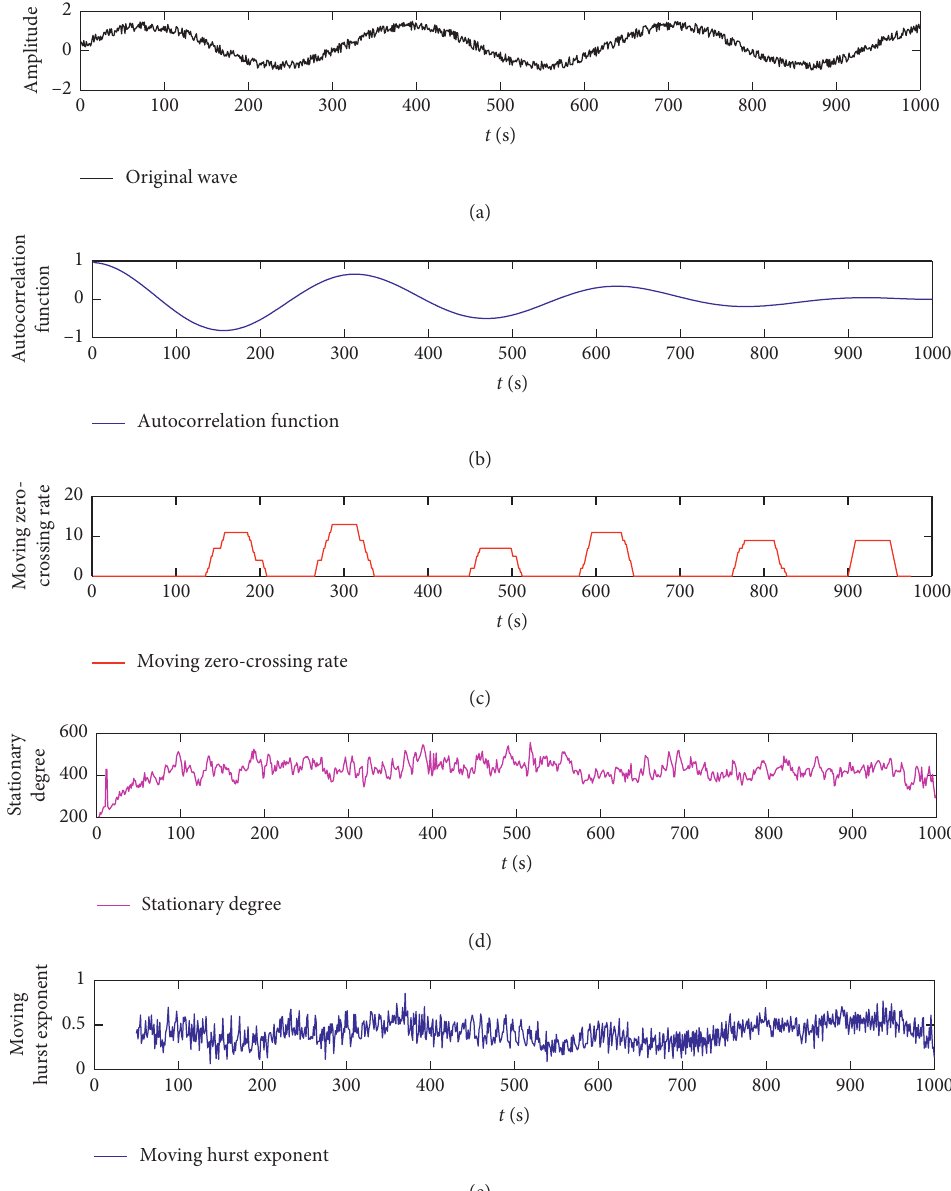
Figure 2: Analysis of sinusoidal superimposed white noise signal based on typical